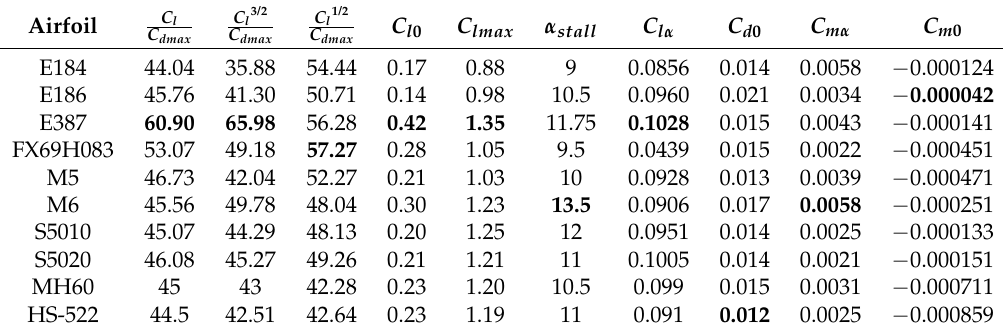
Table 1. Numerically calculated aerodynamic and stability parameters of ten reflexed airfoils by XFLRv5 software.